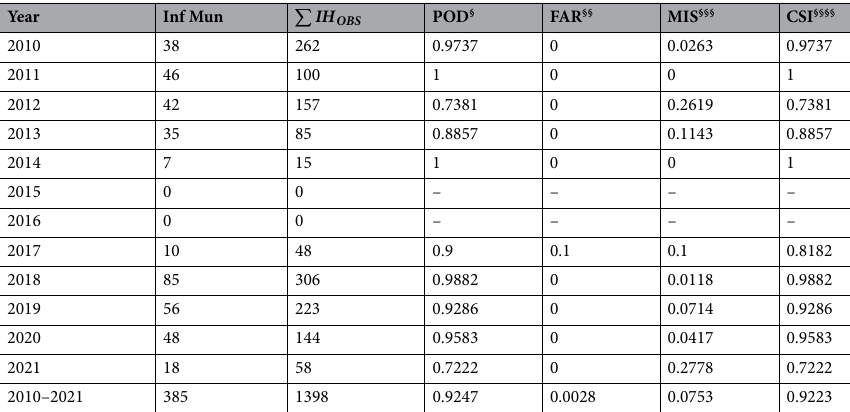
Table 2. Capacity of the MIMESIS-2 model to correctly model laboratory-confirmed human WNV cases by year and in the whole observed time period. Reported are the single evaluation criteria (POD, FAR, MIS, CSI) and the number of municipalities with at least one laboratory-confirmed human WNV case (Inf Mun) and the total number of laboratory-confirmed human WNV cases in Greece ( (cid:31) IH OBS ). § POD = Hits /( Hits + Misses ) . §§ FAR = ( FalseAlarms )/( Hits + FalseAlarms ) . §§§ MIS = Misses /( Hits + Misses ) . §§§§ CSI = Hits /( Hits + FalseAlarms + Misses ) . with Hits (municipalities with cases both observed and simulated for a specific year), False alarms (municipalities with cases simulated but not observed for a specific year), and Misses (municipalities with cases observed but not simulated for a specific year).